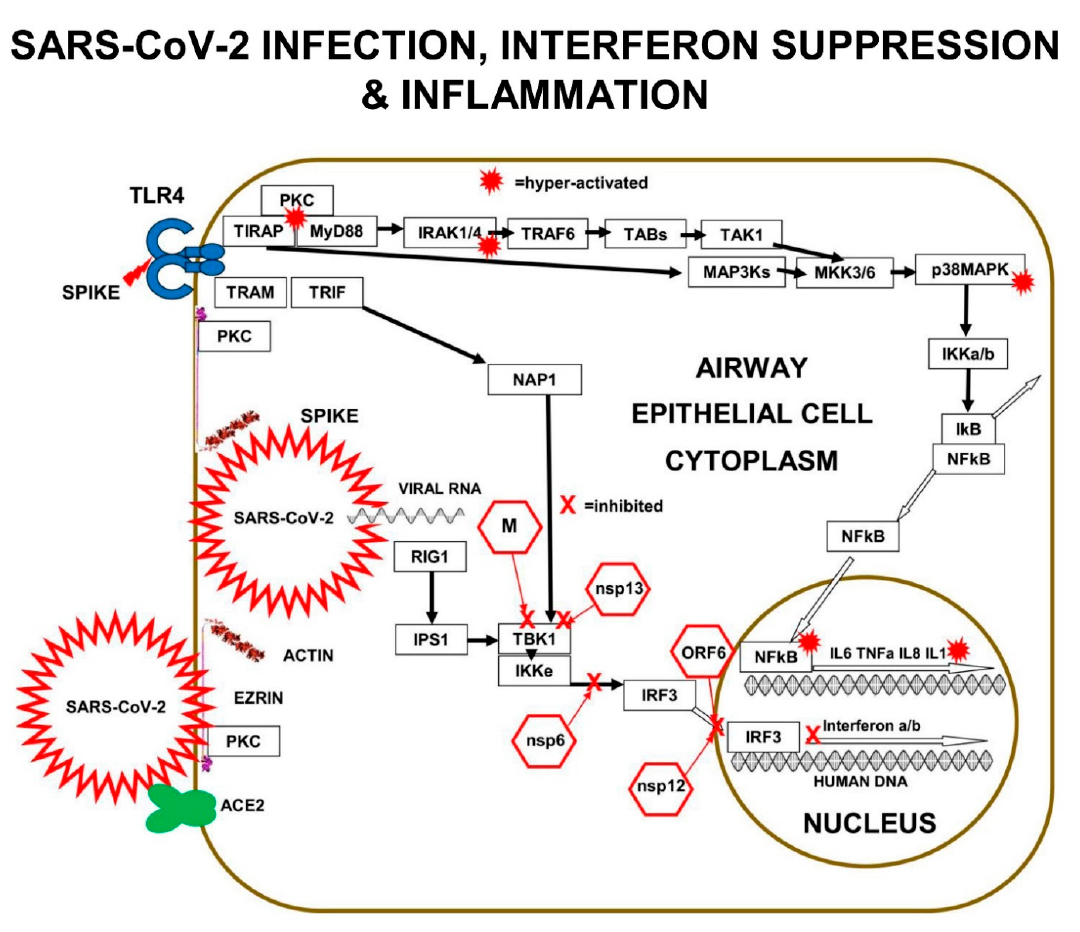
Figure 2. SARS-CoV-2 amplification of inflammation signalling and suppression of interferon sig- nalling. SARS-CoV-2 Spike (S) protein triggers TLR4 and other Pattern Recognition Receptors to